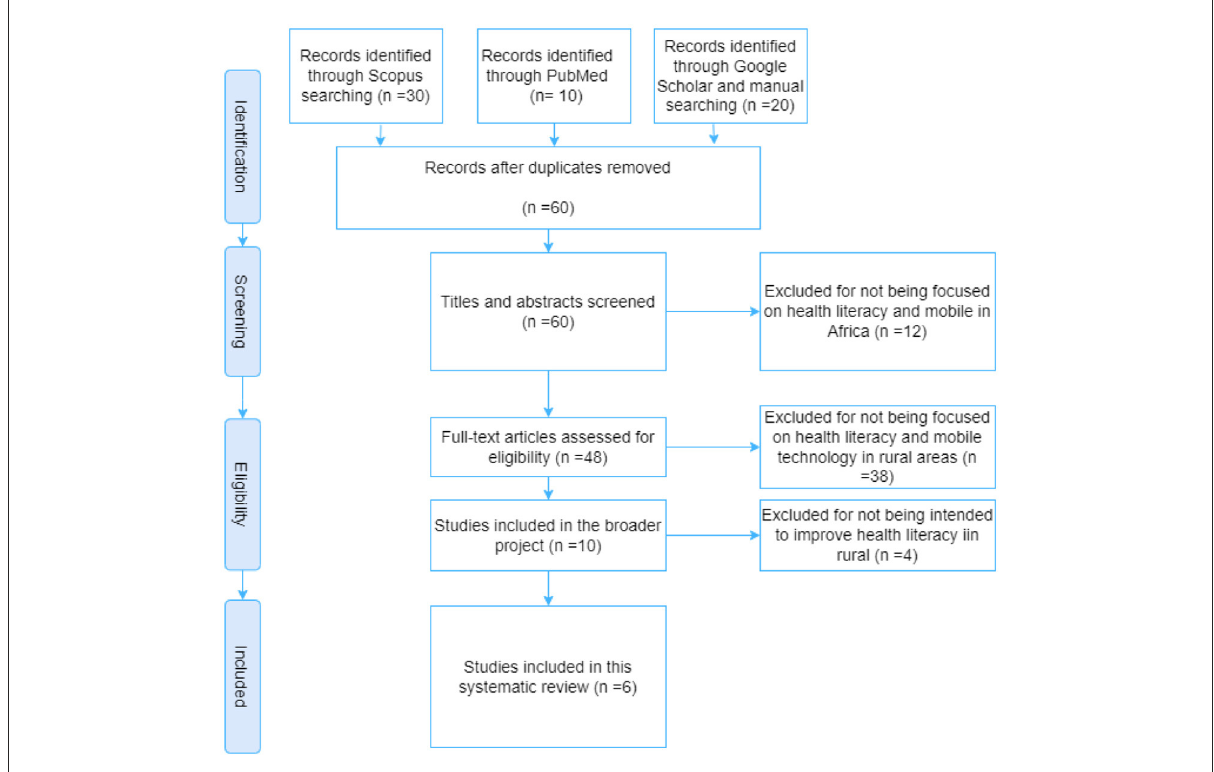
FIGURE1 Flow diagram for the study selection